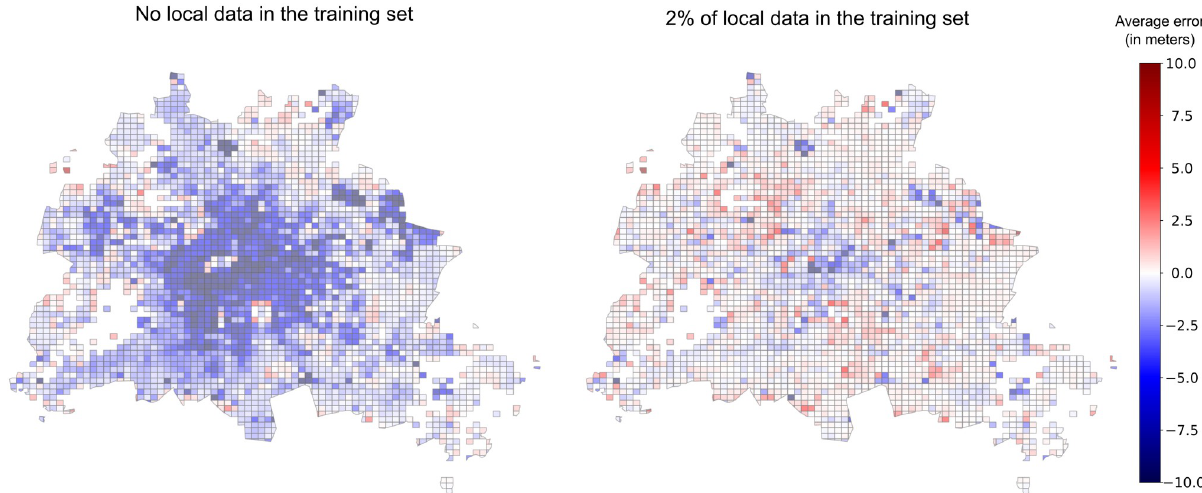
Fig 5. Prediction errors in Berlin for Experiments 1 (no local data) and Experiment 2 (2% of local data). The errors (in meters) are aggregated on a grid for better readability, and depicted by a color gradient. The presence of local data in Experiment 2 starkly reduces the errors and the occurrences of under-prediction, especially in the center of